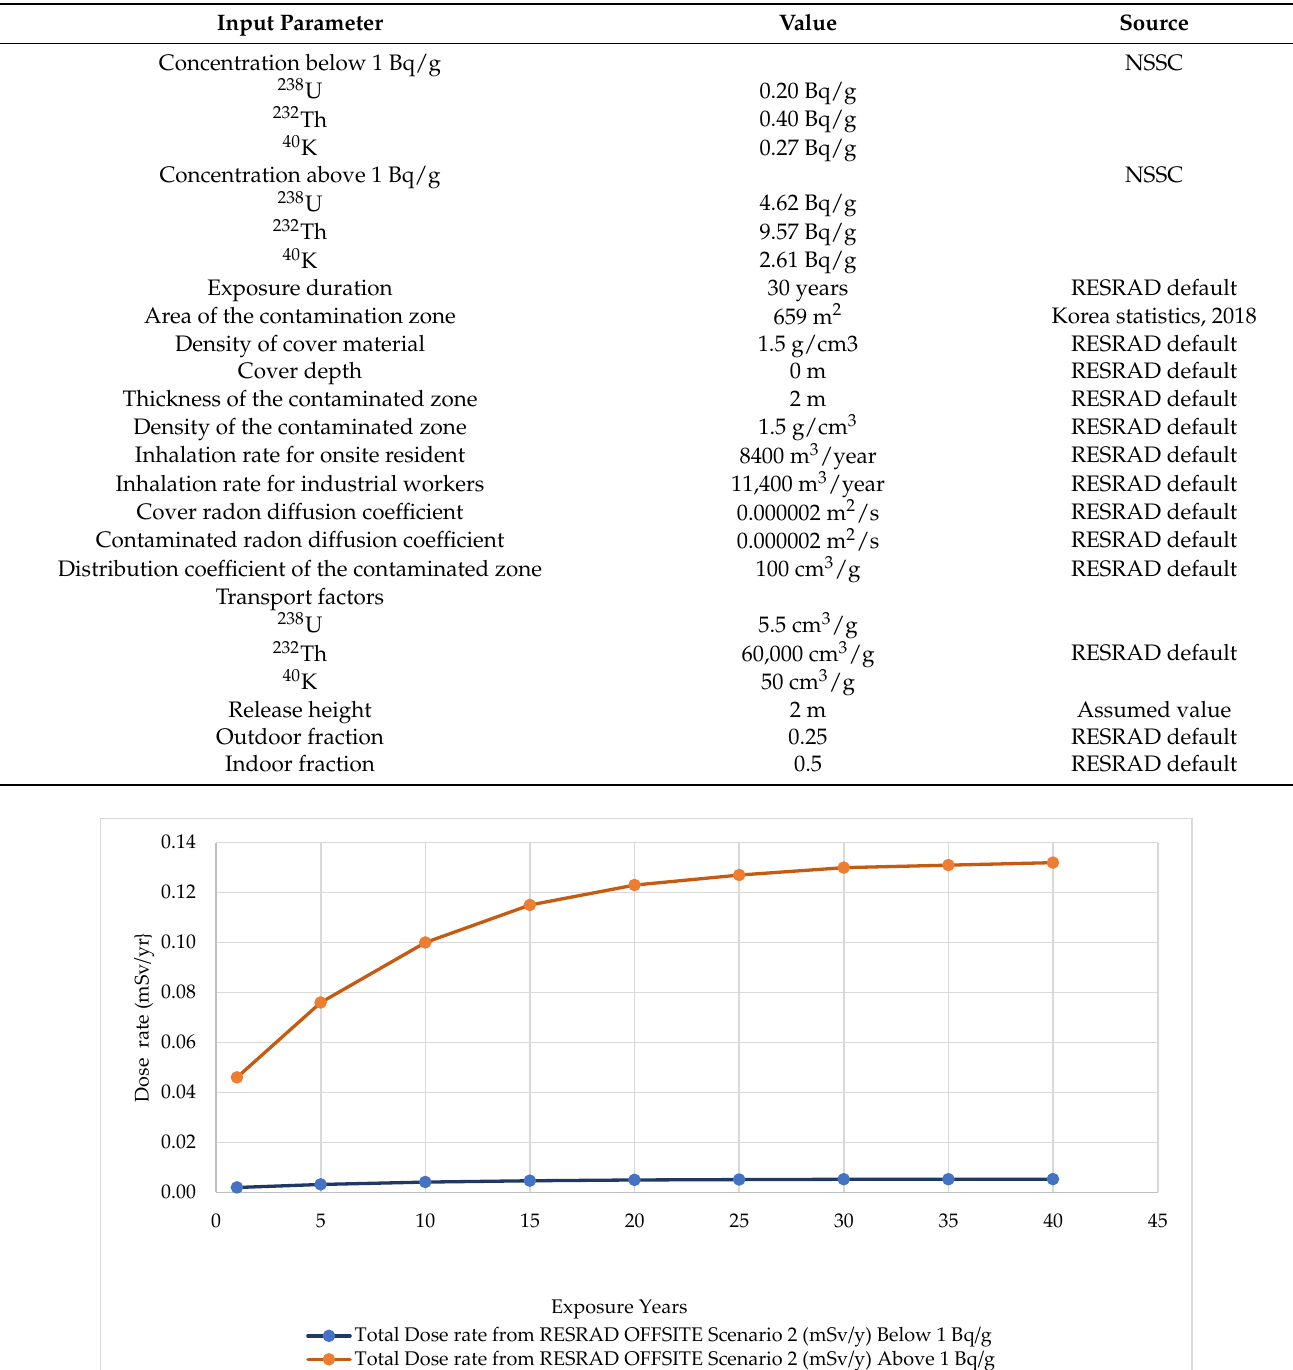
Table 4. Input values used in RESidual RADioactive codes.